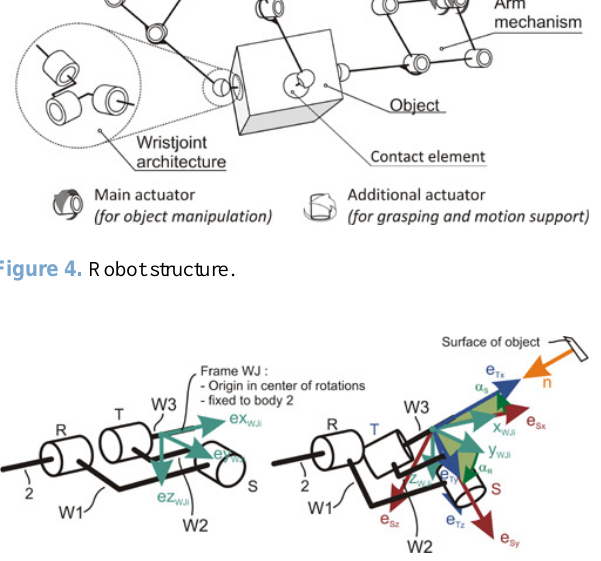
Figure 5. Wrist joint structure with frames and denotations. Left: center joint position. Right: general joint position.